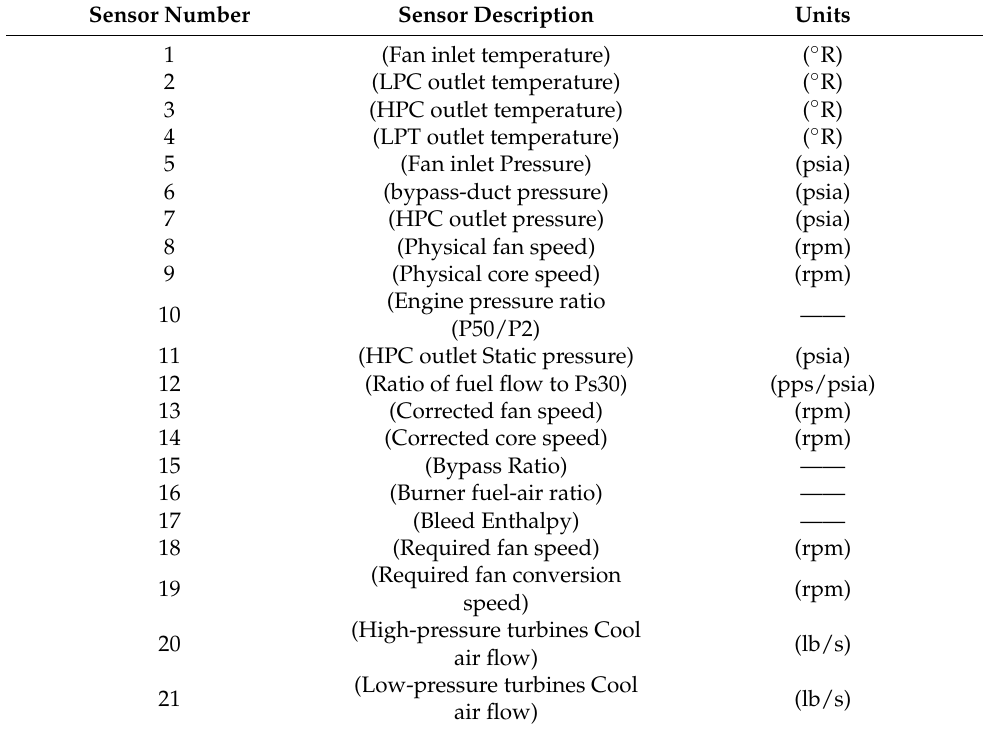
Table 2. Data description of turbofan engine sensor.